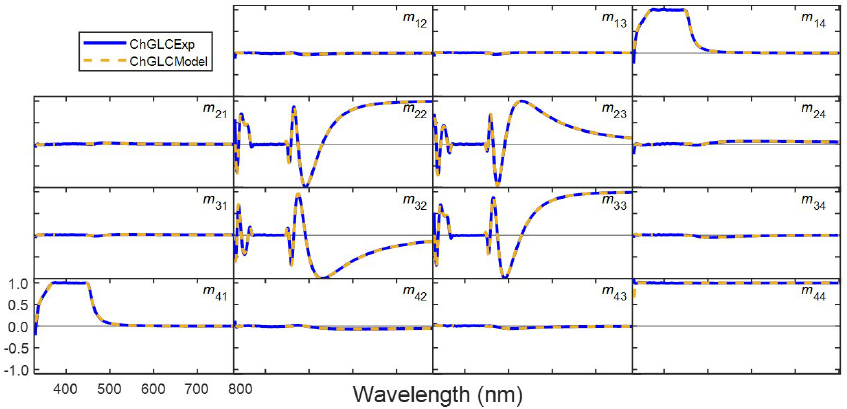
Figure 10. Transmission Mueller matrix of the ChGLC sample (solid curve) and the best fit obtained using Equation (12) (dashed